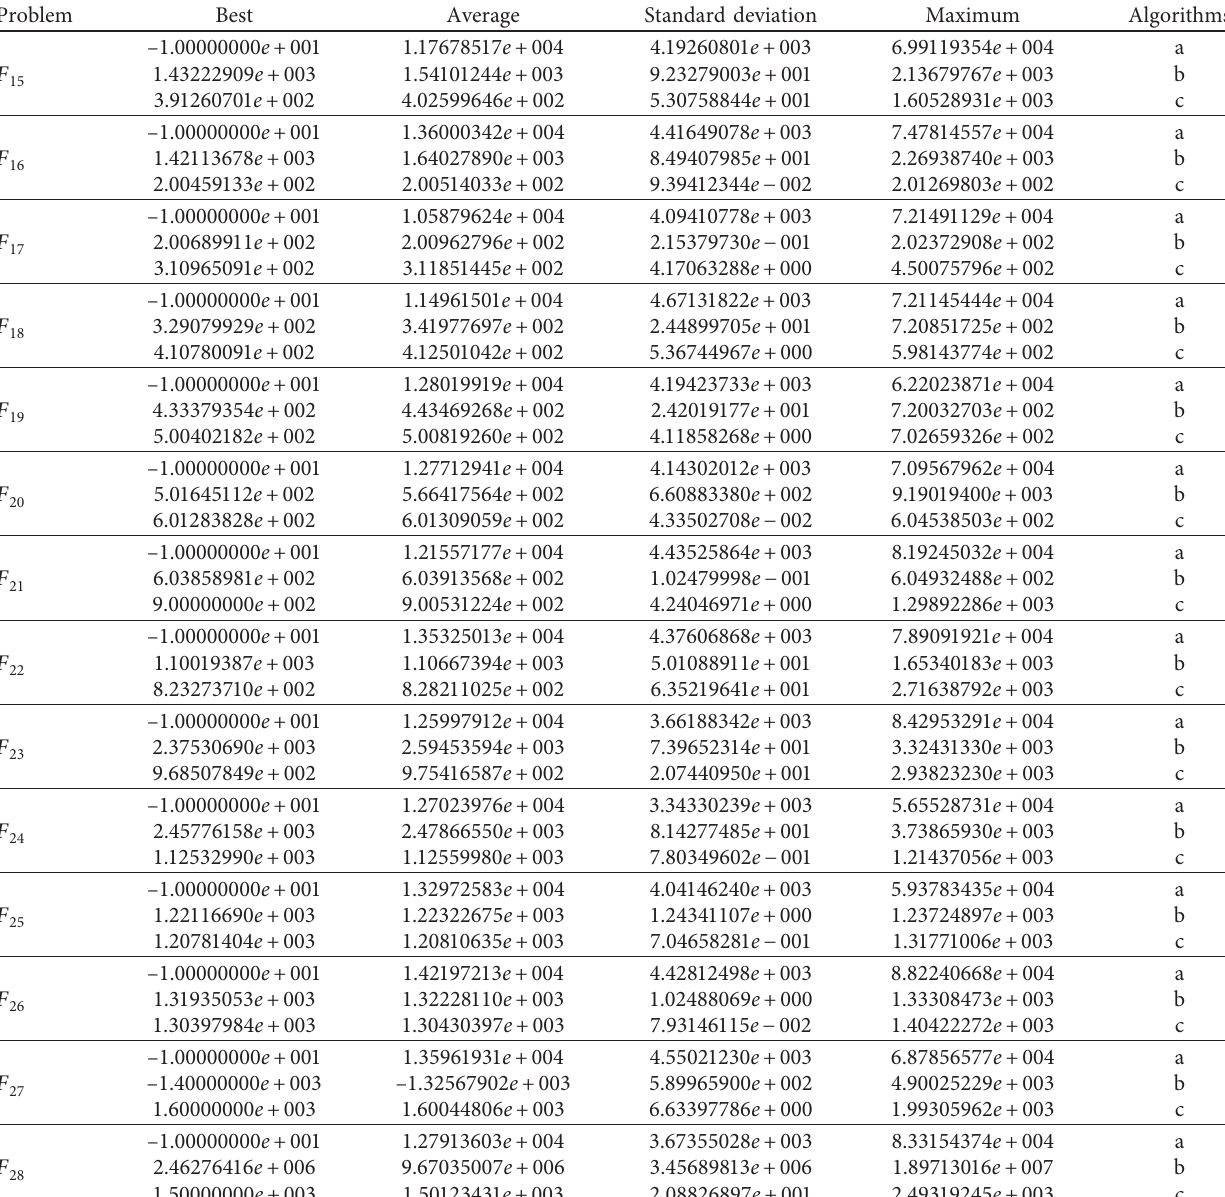
Table 5: The experimental results of (a) MSIA, (b) ACO, and (c) FA by solving the CEC ′ 13 in 30 dimensions